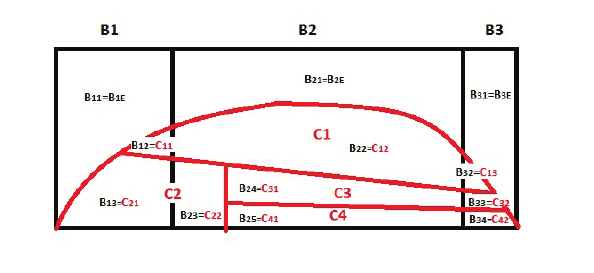
Figure 2 { Areal Data Misalignment: graphical representation of the problem considered in the simulation exercise (source zones in black contour, target areas in red).